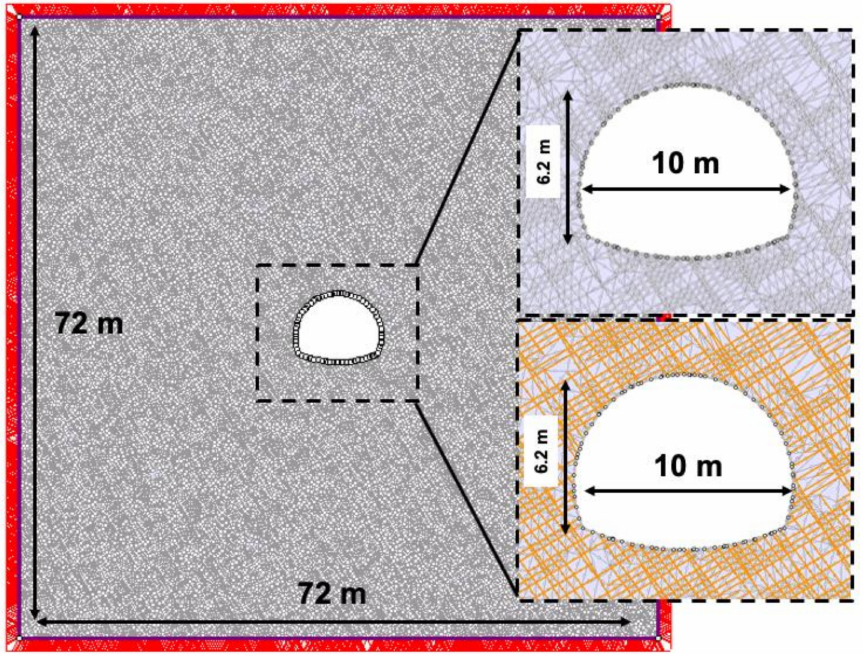
Figure 13. Model geometry, mesh set up and boundary